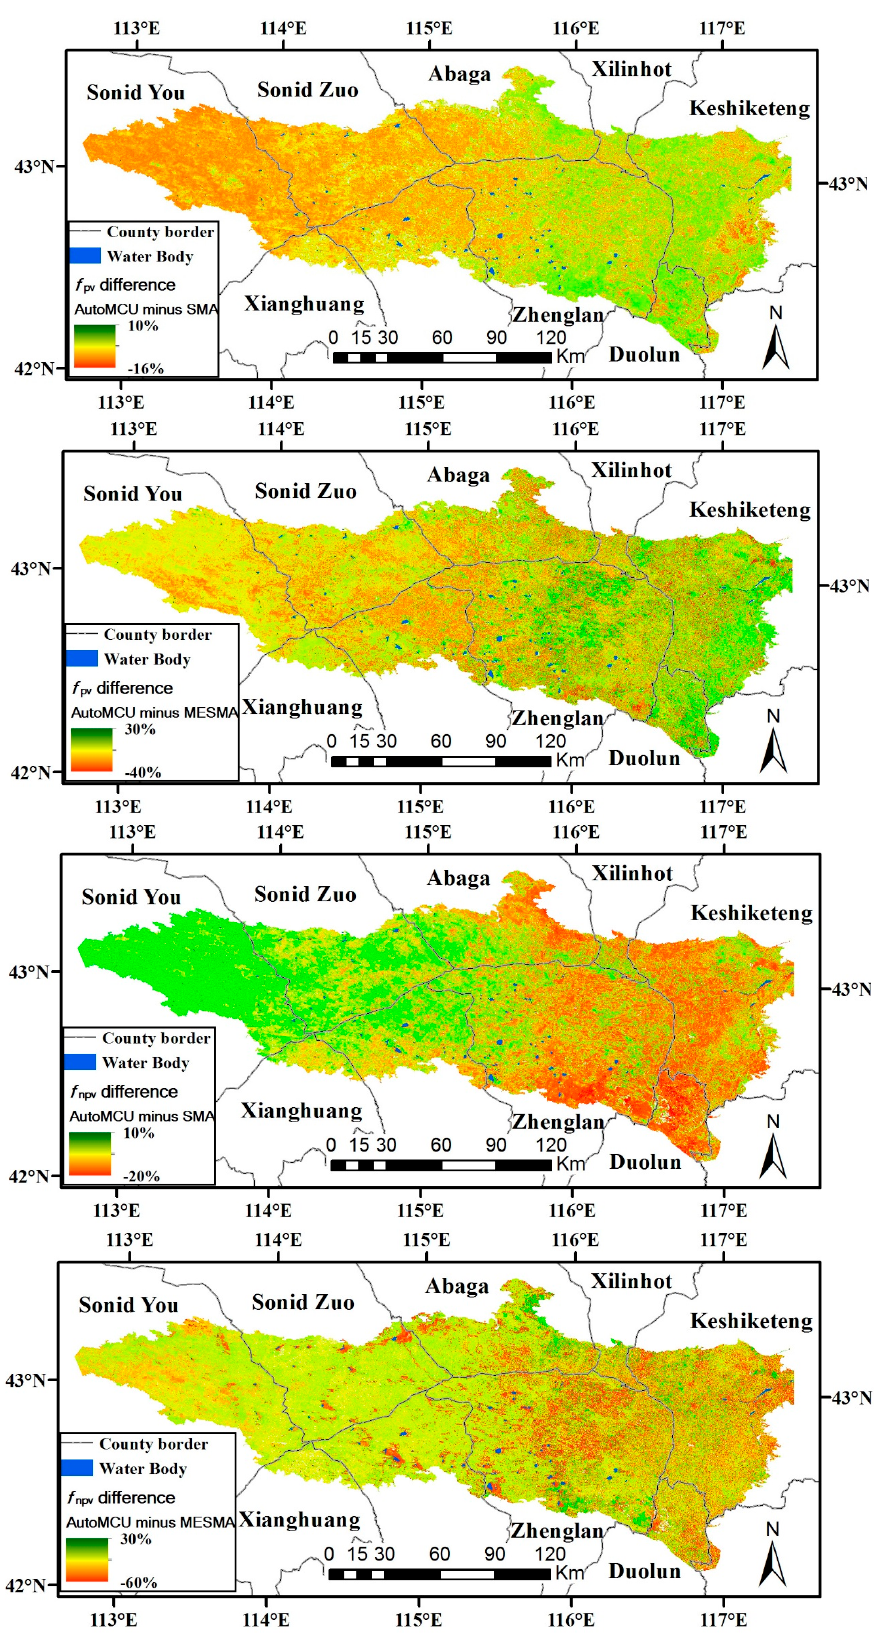
Figure 8. fpv and fnpv differences based on Spectral Mixture Analysis (SMA), Multi-Endmember Spectral Mixture Analysis (MESMA) and Automated Monte Carlo Unmixing Analysis (AutoMCU).